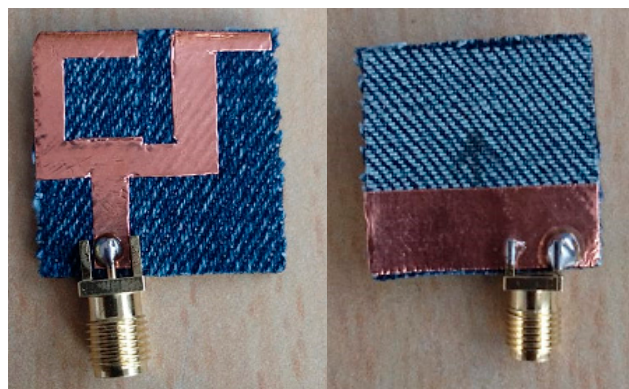
Figure 3. Optimized textile ultra-wideband (UWB) fabricated antenna.